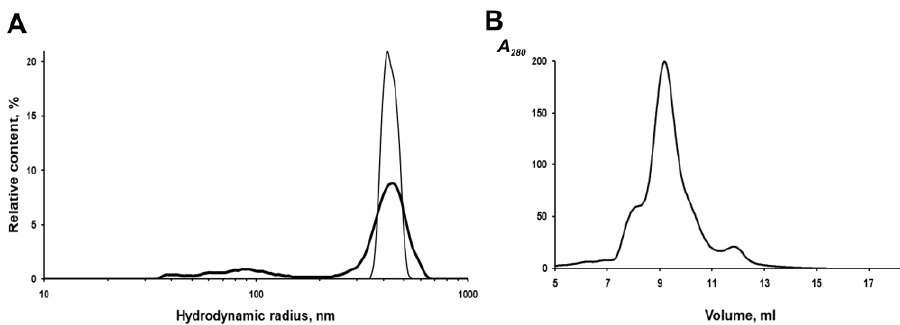
Figure 5. Characteristic of PldA-GFP IBs. ( A ) Particle size volume distribution of IBs in PBS (20 μg/mL): IBs intact (thin line), IBs after passing through a 0.1 mm needle and sonication (thick line); ( B ) Gel filtration chromatography of PldA-GFP solubilized in 0.1% SDS, 50 mM Tris-HCl buffer, pH 8.0, on a Superdex 200 HR column.